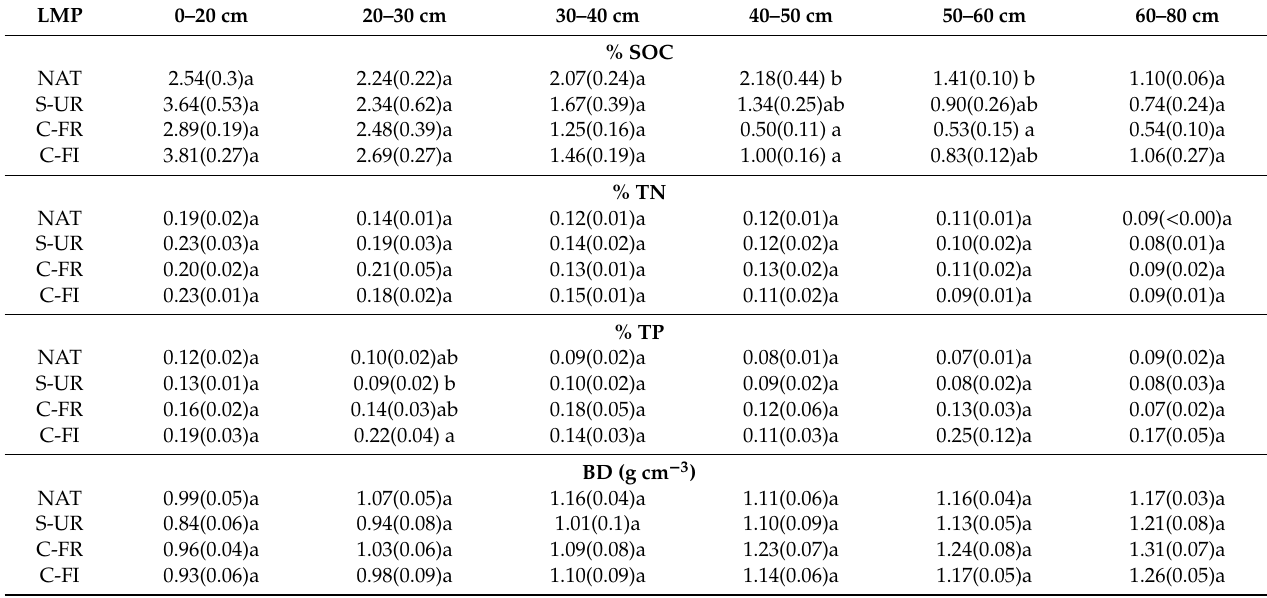
Table 3. Mean percentages of: soil organic carbon (SOC; top rows); total nitrogen (TN; middle top); total phosphorous (TP; middle bottom); and bulk density (BD, bottom) at each sampling depth for the four land management practices (LMPs). Bracketed numbers are standard errors (n = 5). Di ff erent letters in the same column indicate significant di ff erence ( p < 0.05) between LMPs determined using one-way analysis of variance and Tukey’s honestly significant di ff erence post hoc